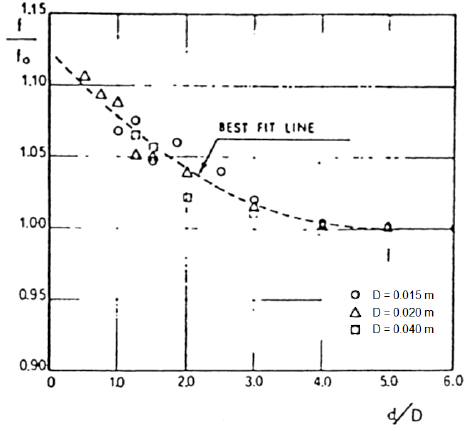
Figure 4. Vortex shedding frequency vs. wall distances.